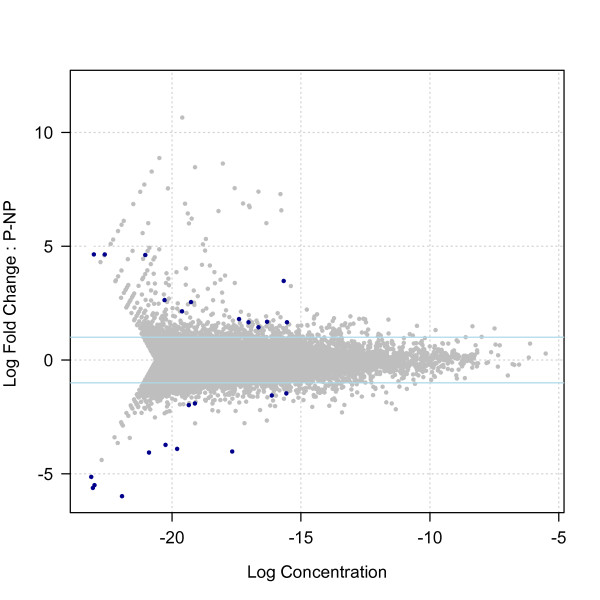
Differential expression in predator-exposed and non-exposed fish. The differently expressed genes are in blue, and the others in grey. The x-axis is an estimate of the relative abundance of the transcript (a measure of the average expression level for each sequence across the two groups, Ag), and the y-axis is a measure of differential expression, Mg. The solid light-blue horizontal lines show where genes with 2-fold differences in expression would fall, so all the genes with differential expression in this analysis show > 2 fold differences between treatments. Reference sequences with very low or very high values of Mg have their fold-change values compressed to fit within the [-10, +10] interval. The compressed values usually represent sequences with zero counts in one treatment group.